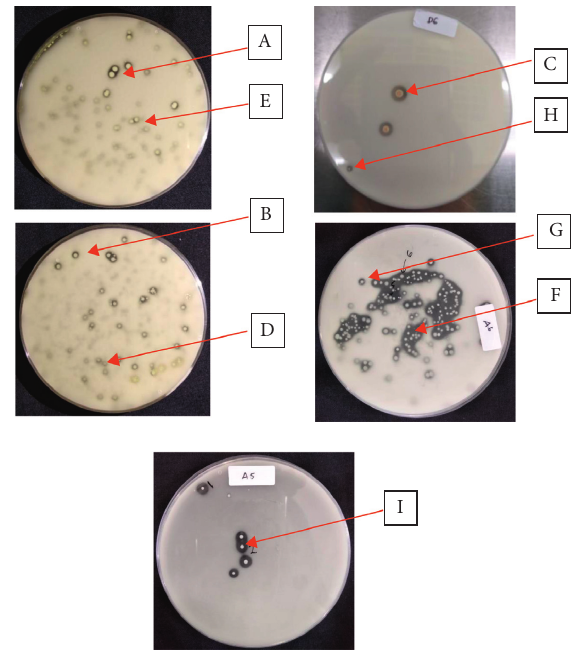
Figure 1: Selected colony morphology of catfish-autochthonous